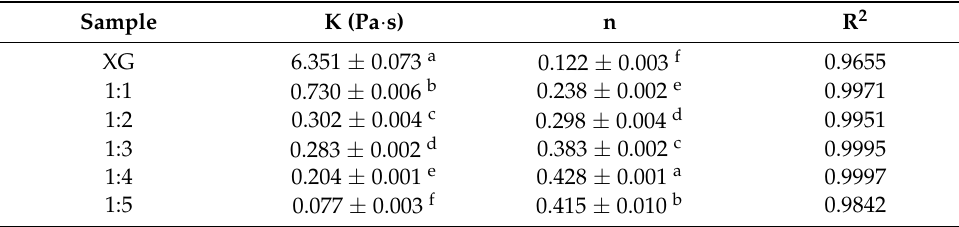
Figure 3. Rheological characterizations of coating solutions at 1:0 ( a ), 1:1 ( b ), 1:2 ( c ), 1:3 ( d ), 1:4 ( e ), 1:5 ( f ) ( v / v ). 1:0 = XG solution; 1:1 = XG and liposome (1:1, v / v ) mixed solution; 1:2 = XG and liposome (1:2, v / v ) mixed solution; 1:3 = coated with XG and liposome (1:3, v / v ) mixed solution; 1:4 = XG and liposome (1:4, v / v ) mixed solution; 1:5 = coated with XG and liposome (1:5, v / v ) mixed solution. XG: xanthan gum. Table 2. Power–law parameters of coating solutions.